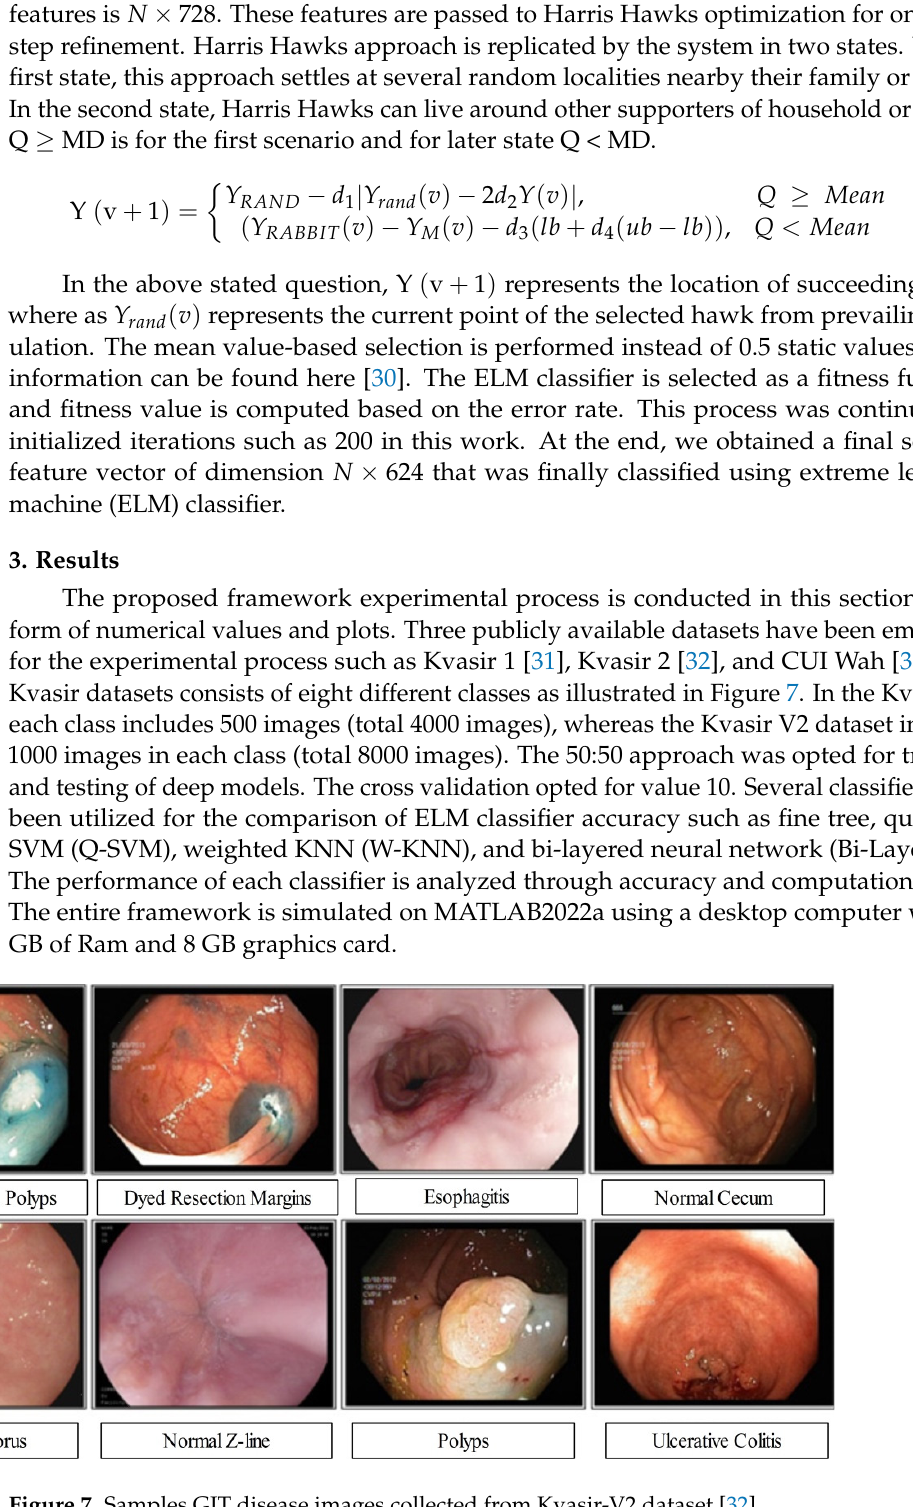
Figure 7. Samples GIT disease images collected from Kvasir-V2 dataset